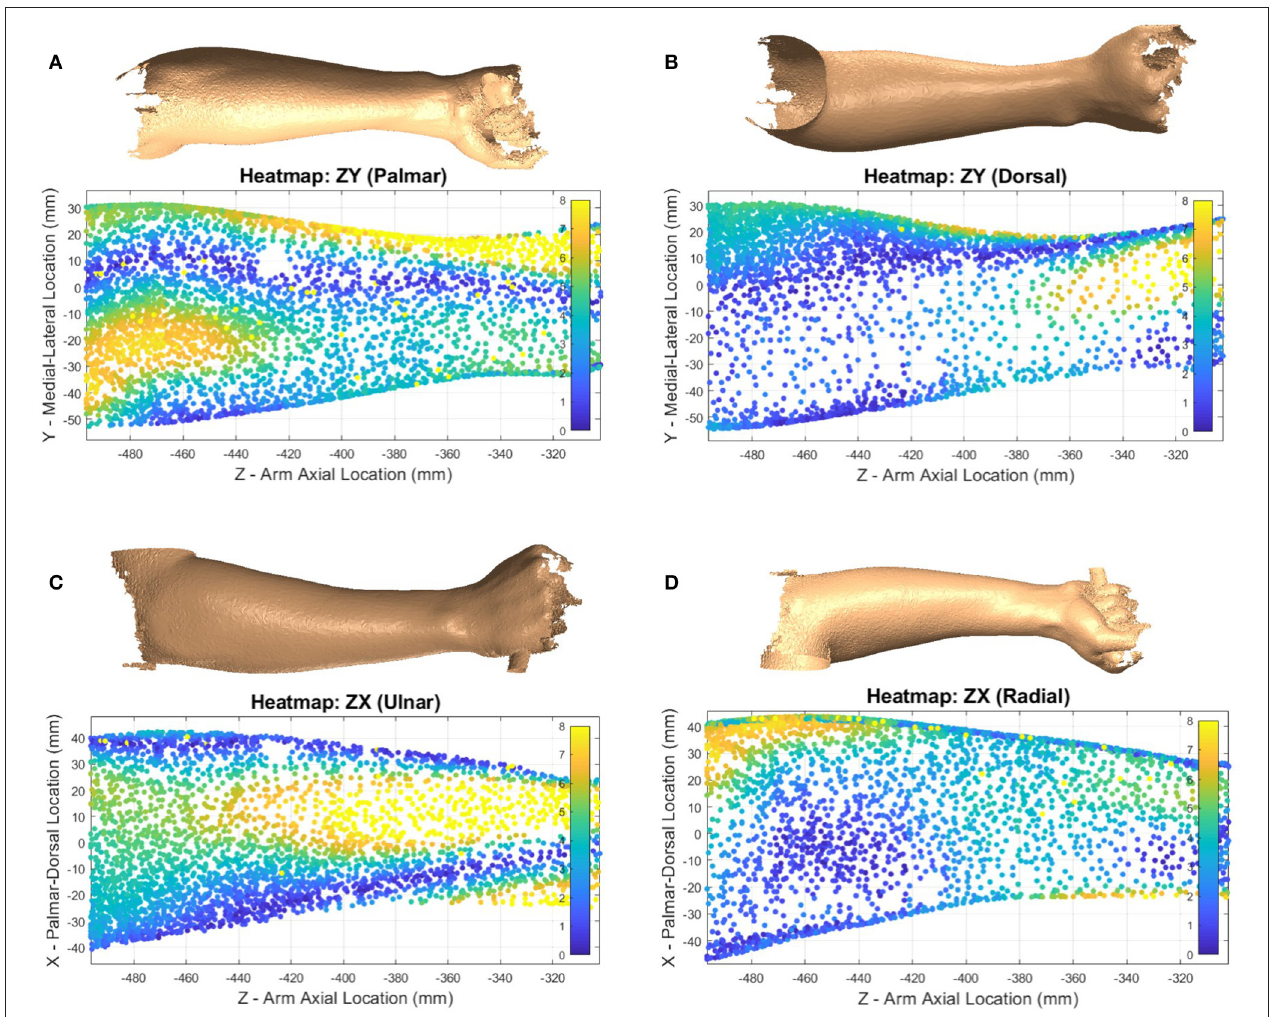
FIGURE 11 | Heatmap showing supination ellipse-fit data from model CS1 compared to the raw pronation data showing evaluate volume changes between poses for subject 2. Heatmaps shown from palmar side ZY plane (A) , dorsal side ZY plane (B) , ulnar side ZX plane (C) , and radial side ZX plane (D) represent the amount of deviation between pronation and supination in